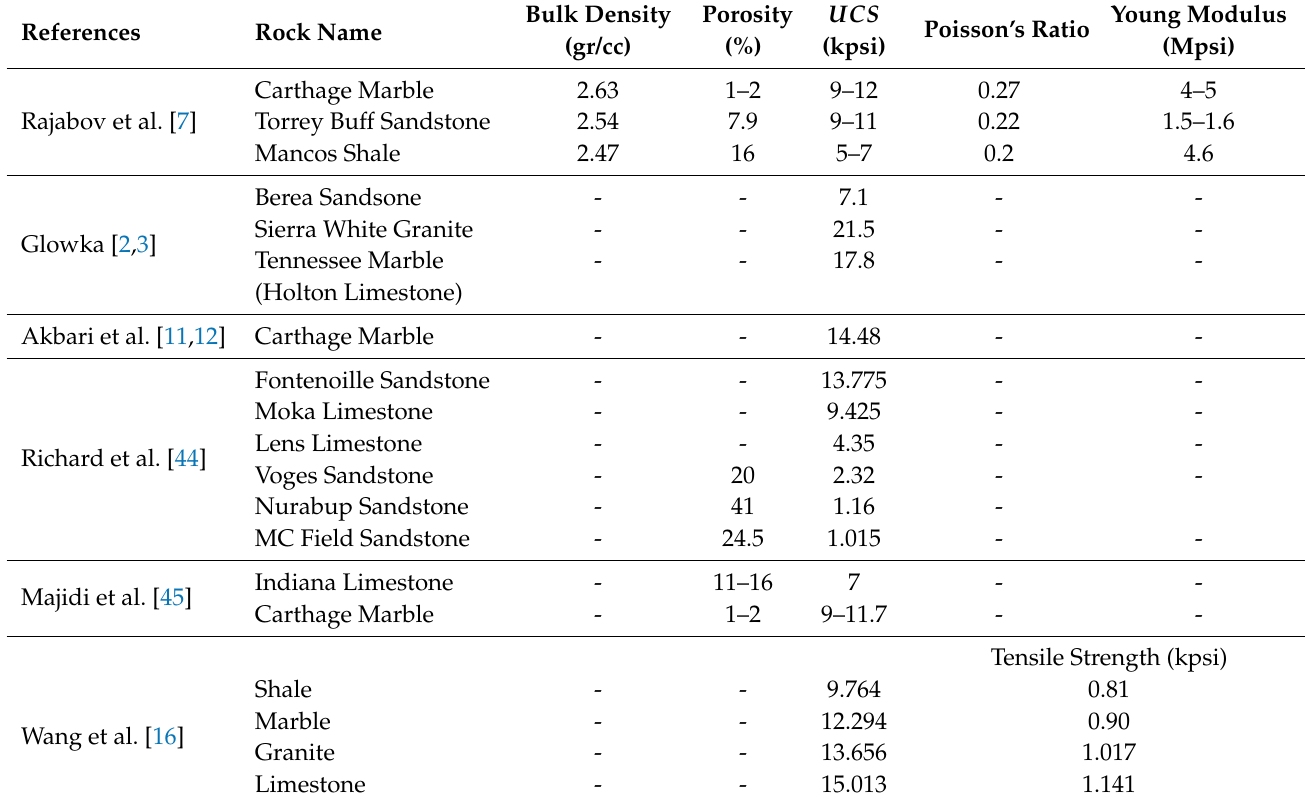
Table 1. Physical properties of rock for data utilized in this